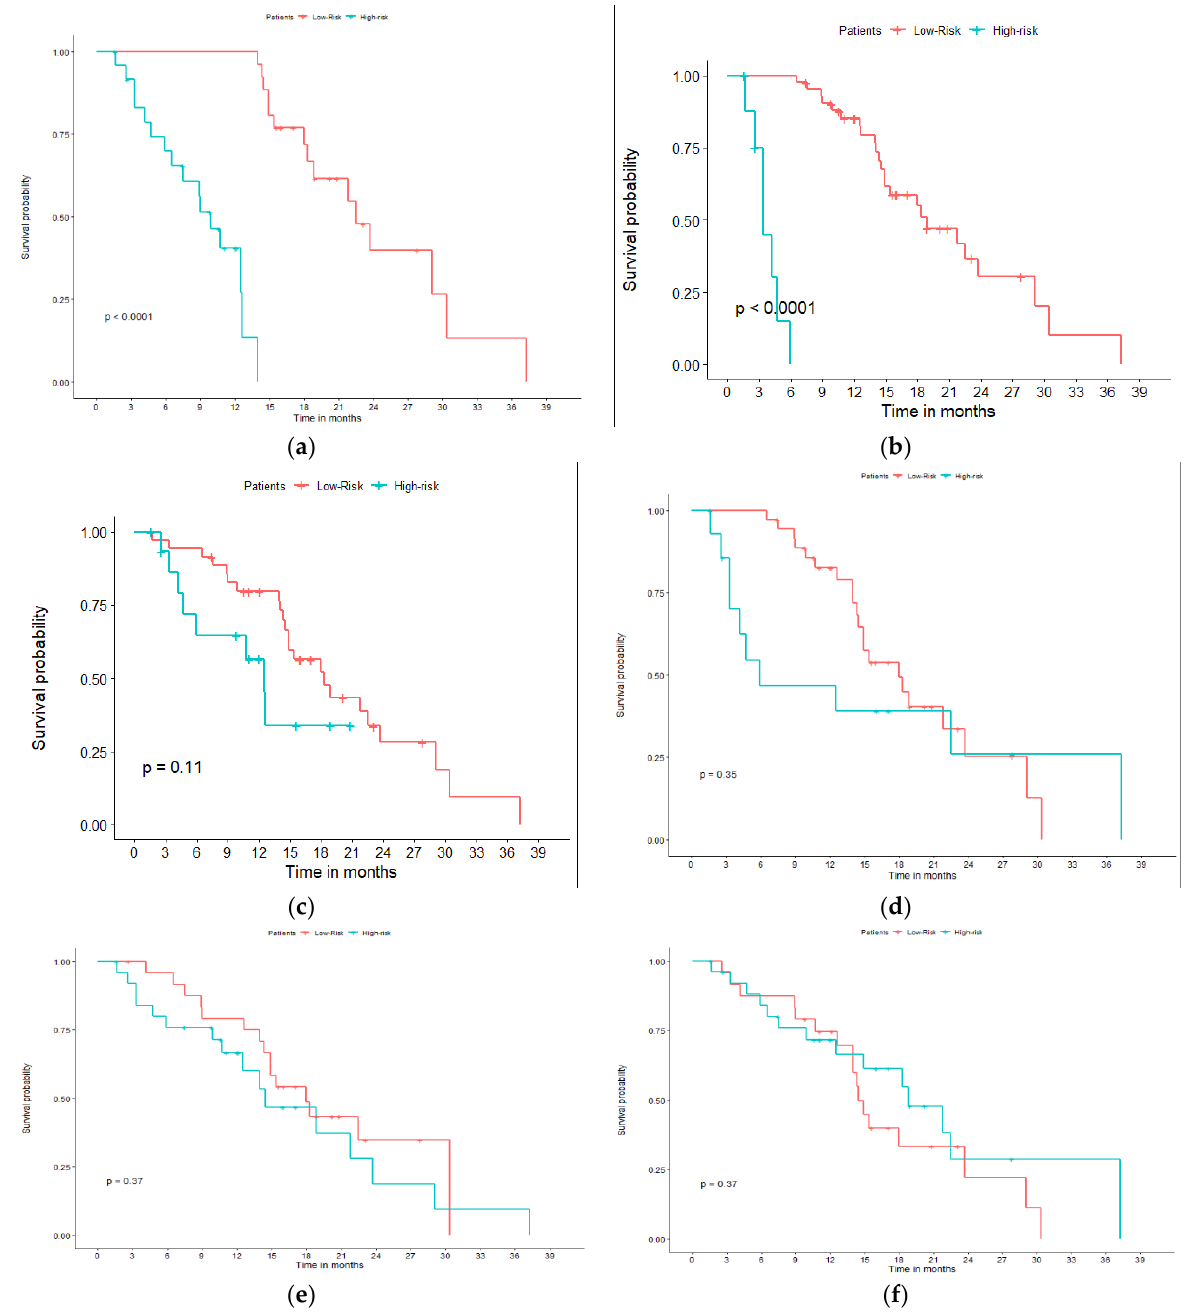
Figure 2. Kaplan – Meier curves obtained in the testing cohort for the two endpoints: ( a , c , e ) median overall survival (OS) and ( b , d , f ) OS <6 months. ( a , b ) is the ground-truth, ( c , d ) is obtained with the groups of patients classified by the probabilities averaging. ( e , f ) Stratification achieved with stage II vs. III.